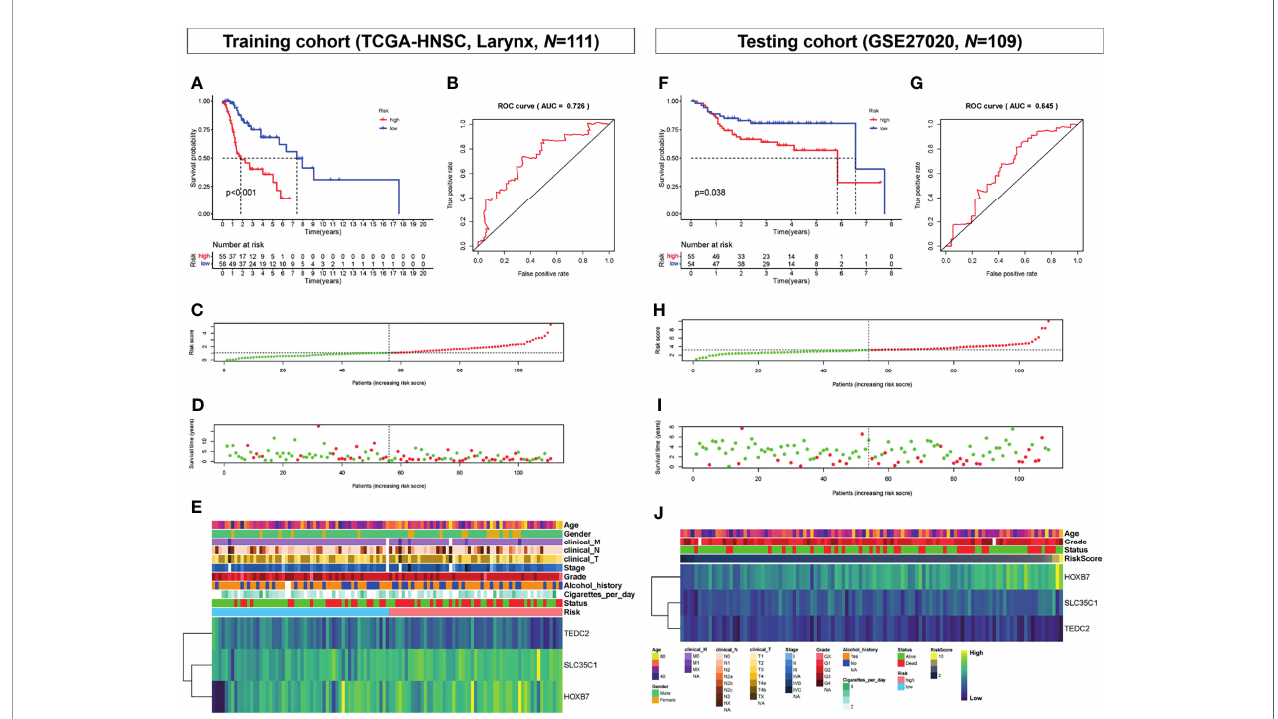
FIGURE 4 | Prognostic analysis of the key genes. (A) Overall survival between high-risk score and low-risk score groups in the training cohort (TCGA-HNSC, larynx, N = 111). (B) ROC curve analysis between high-risk score and low-risk score groups in the training cohort. (C) Risk score distribution of patients in the training cohort. (D) Survival status scatter plots for patients in the training cohort. (E) Expression patterns of risk genes in the training cohort. (F) Overall survival between high-risk score and low-risk score groups in the testing cohort (GSE27020, N = 109). (G) ROC curve analysis between high-risk score and low-risk score groups in the testing cohort. (H) Risk score distribution of patients in the testing cohort. (I) Survival status scatter plots for patients in the testing cohort. (J) Expression patterns of risk genes in the testing cohort. ROC, receiver operating characteristic; AUC, area under the